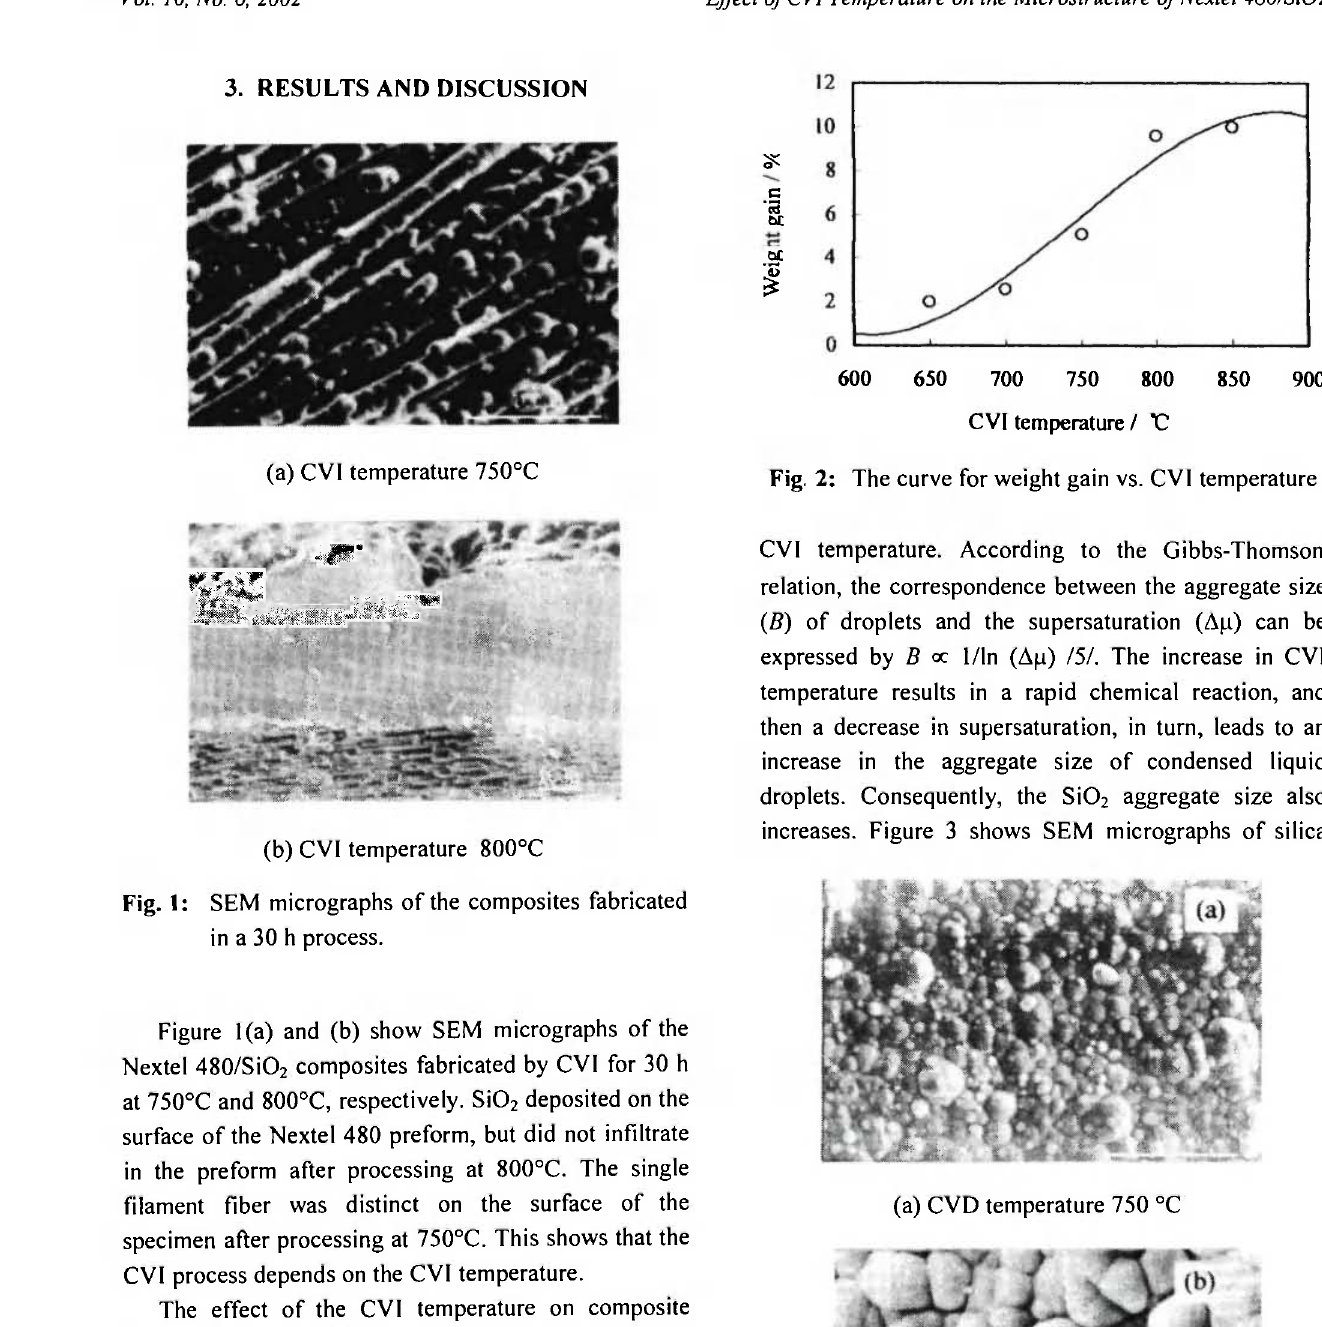
Fig. 1 : SEM micrographs of the composites fabricated in a 30 h process.